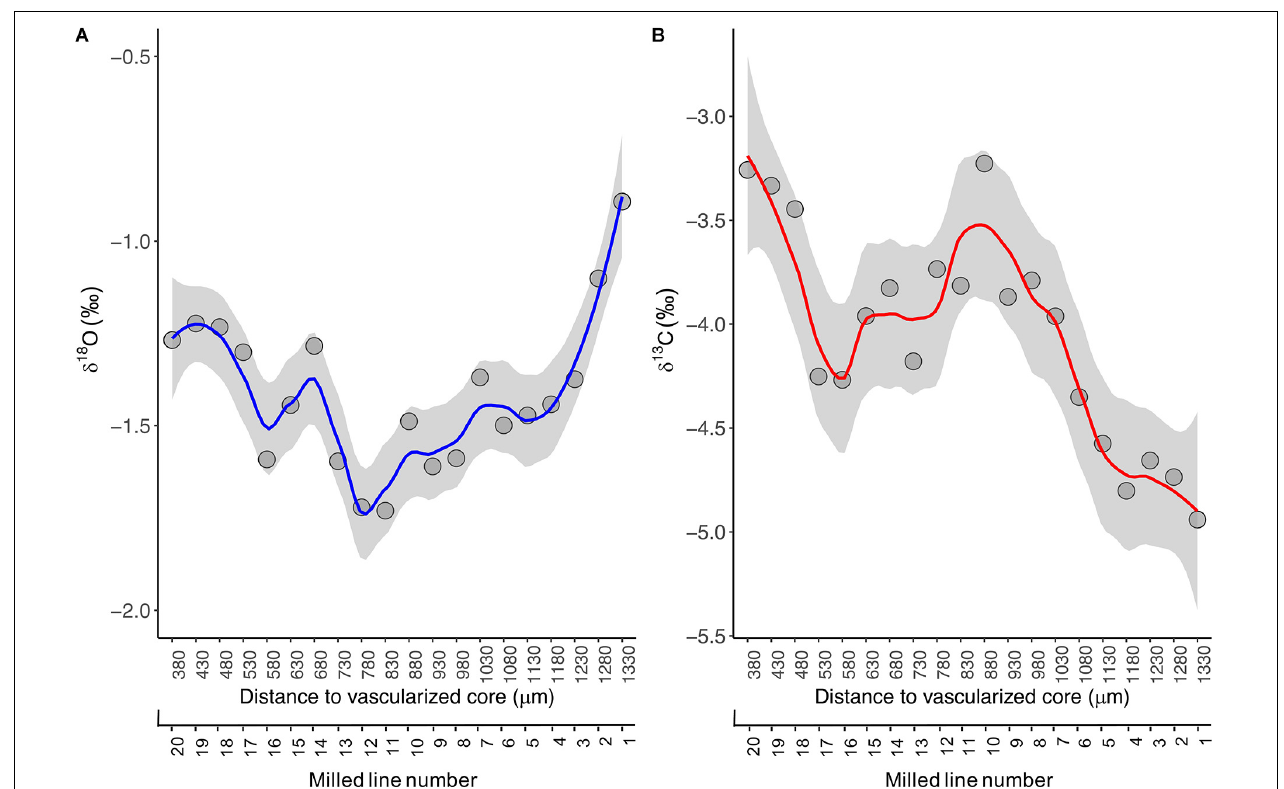
FIGURE 4 | LOESS regression curves (solid lines) with smoothing based on 95% confidence intervals (grey area) for the δ 18 O spine (A) and δ 13 C spine (B) values assayed across growth intervals in the fin spine section. Data was plotted in function of distance to the fin spine edge ( µ